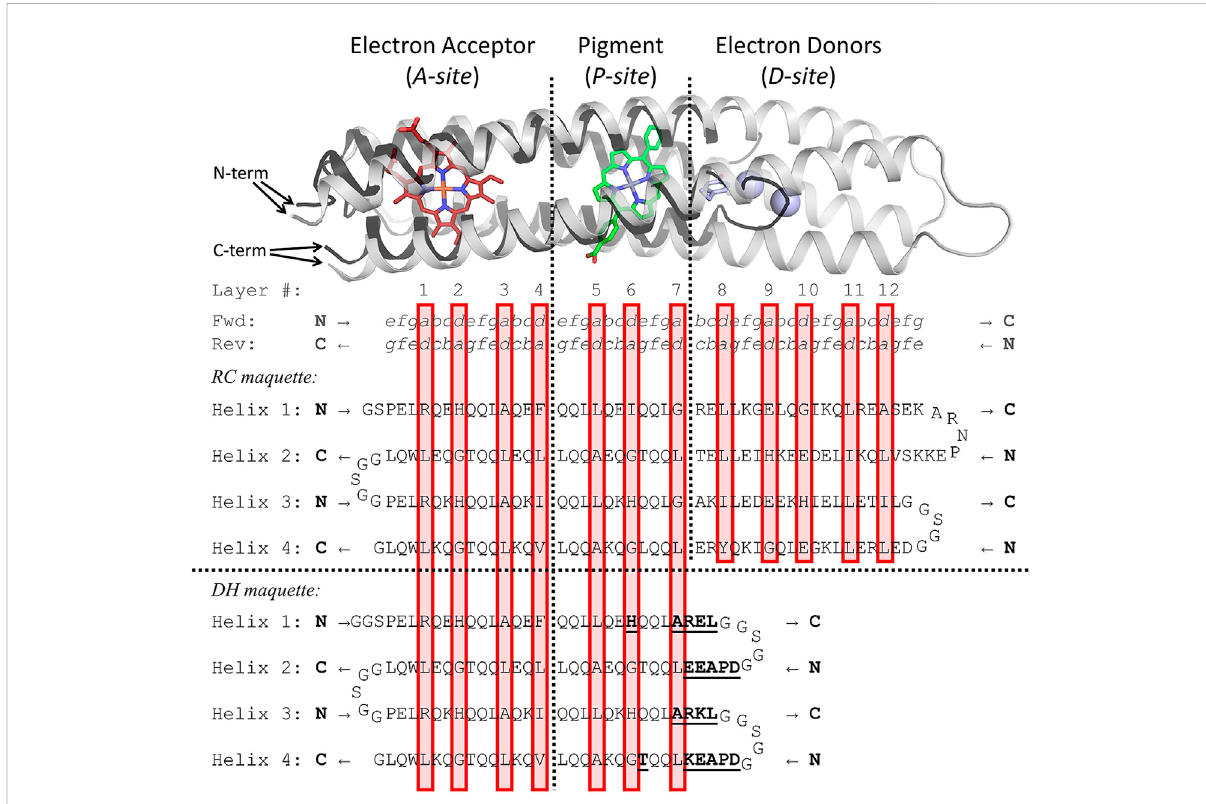
FIGURE 5 Sequence and structure comparison of RC and DH maquettes. Above, an RC maquette model based on crystal structures in white helices is overlaidwiththeRoseTTAFold(model1)predictedstructureoftheDHmaquetteinblackhelices.TheRoseTTAFoldpredictionhasahighcon fi dence score of 0.85. (AlphaFold predicted models are similar). The sequence diagrams below align the RC and DH maquette sequences. Differences betweenthemaquettesinhelicalsegmentsareindicatedinboldandunderlinedintheDHmaquettesequence.AsinFigure2,coiledcoilheptad positions a through g aredenotedinthetoptworows,and a / d layersofthehydrophobiccoreareindicatedbyredboxes. Theaminoacidsequences haveeachhelixwrittenonanewlinewithhelices2and4writteninreversefromC-terminustoN-terminusasindicatedbyarrowsandboldNorCat the ends of each helix. (Full forward sequences are given in Supplementary Table